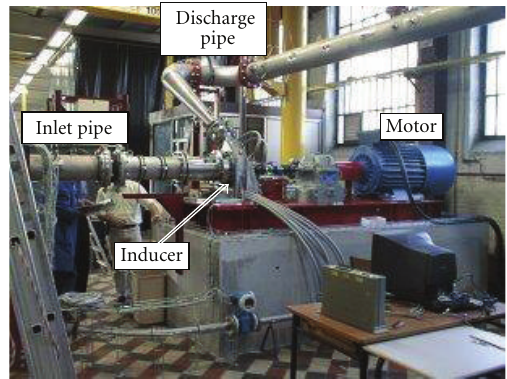
Figure 3: General view of the LML large test